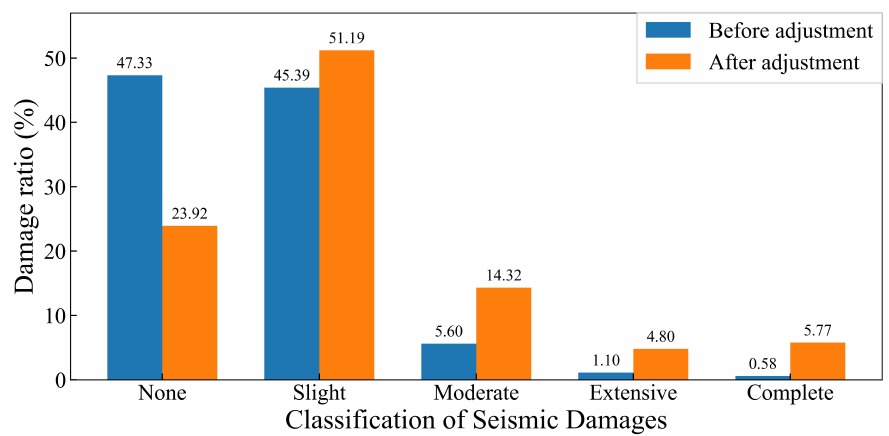
Figure 4. The ratio of each damage state before and after amplitude